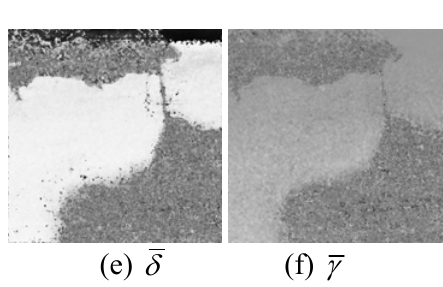
Figure 7. GLCM-based features of T